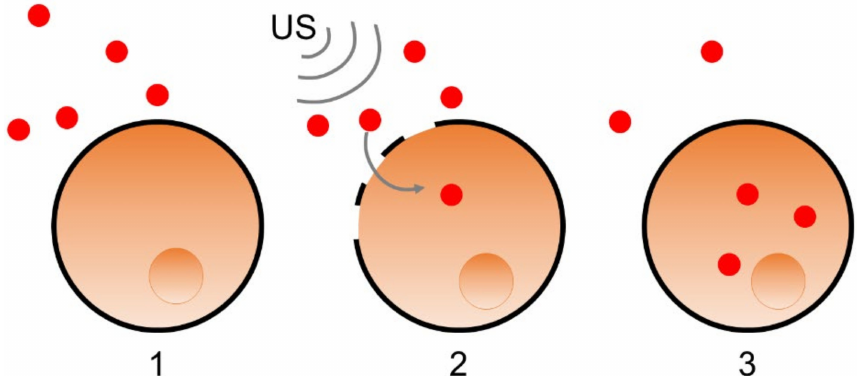
Figure 4. Schematic description of gene or protein transfection (schematized in red dot) into a cell (schematized in orange, with its nucleus in darker orange). The elements to be transferred are in the extracellular medium (1). The cell membrane is disrupted by US (schematized by the grey waves) (2). The cell membrane closes again after integration of the transfected elements